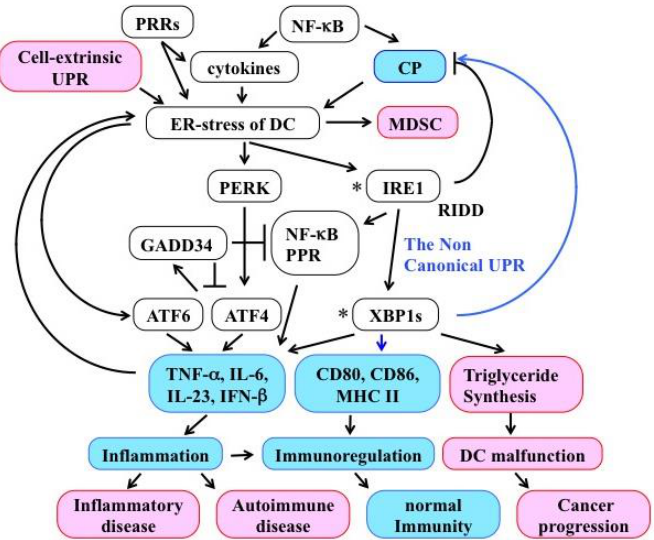
Figure 3. The crosstalk between CP, UPR, and inflammation. Pathogen-related stimuli, such as pattern recognition receptor (PRR) ligation, cytokines, and cell-extrinsic UPR can induce ER stress in Dendritic cells (DCs). Accumulation of unfolded proteins for CP also contributes to trigger / sustain ER stress in DCs. Although ER stress activates the UPR to restore ER homeostasis, the UPR itself accelerates the transcription of several inflammatory cytokines both directly, via UPR-related transcription factors, and indirectly, through the activation of di ff erent signaling cascades (e.g., NF- κ B, PRRs). When the UPR of DCs is over-activated, the immunoregulatory functions of DCs are dismissed and this may result in chronic inflammation and ultimately cancer. However, when the UPR is over-repressed, CP e ffi ciency is impaired. Thus, the non-canonical UPR of DCs has to cope with opposite requirements in order to maintain both ER homeostasis and adequate CP / immune-modulatory functions. The precise molecular mechanisms to evade UPR over-activation are, however, not known, except for the established suppressive function of GADD33. Black arrows indicate activation, T-arrows indicate suppression, blue arrows indicate pathways involved in the non-canonical UPR. The asterisks of IRE1 and XBPs indicate the risk factor for inflammatory disease among the UPR-related